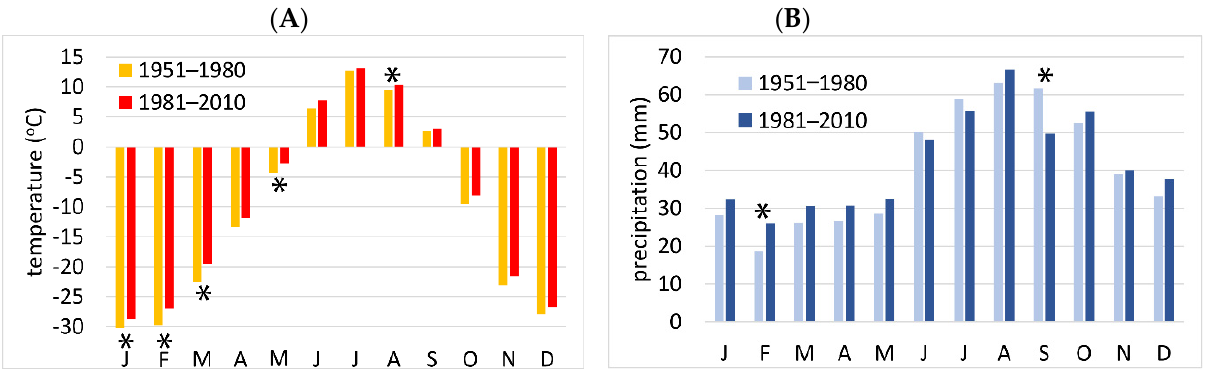
Figure 6. ( A )Annual mean temperature, ( B ) precipitation totals and linear trends. Data derived from gridded CRU TS database v. 4.